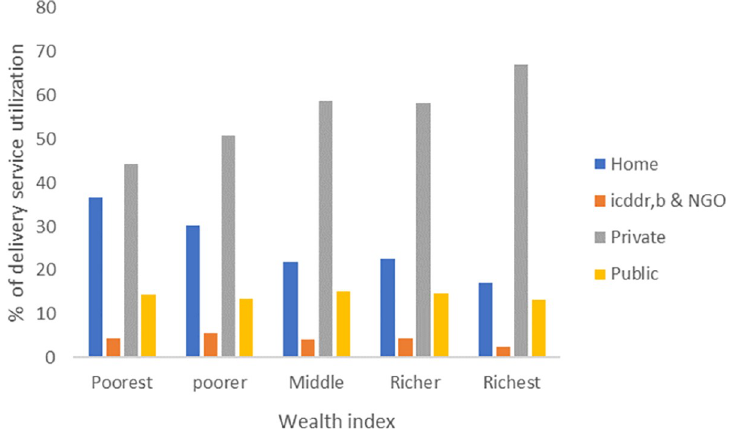
Fig 6. Health facility utilization for facility delivery by wealth